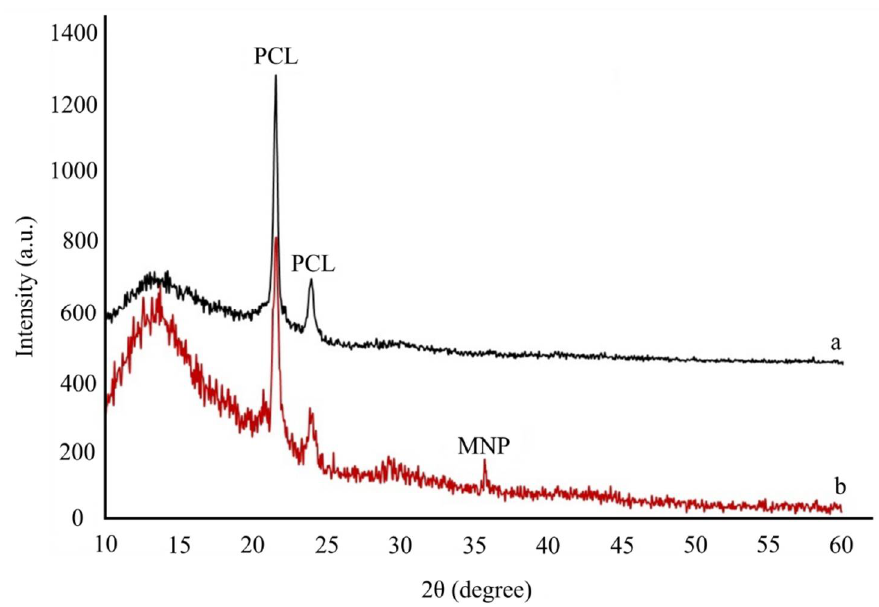
Figure 10. XRD patterns of PCL ( a ) and 5MNP ( b )